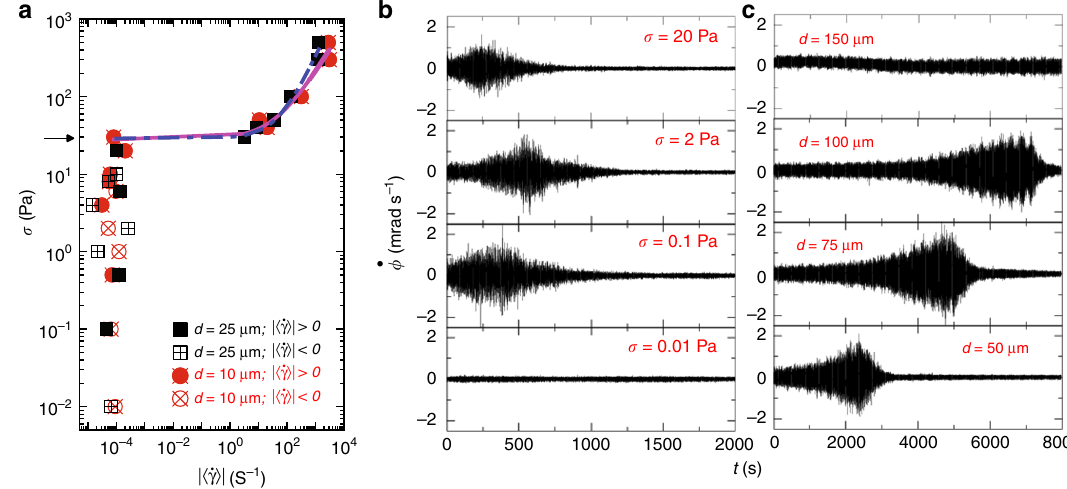
Fig. 1 Steady-state fl ow curves and creep behavior of CTAT nematic . a Applied shear stress ( σ ) versus absolute value of steady-state shear rate ( jh _ γ ij , calculated considering data from 2000s to 8000 s for each stress value) for 39 wt % CTAT + water sample at 30 °C (nematic phase of cylindrical micelles) is plotted for two different sample thicknesses ( d ). Filled symbols indicate positive and empty symbols indicate negative values of h _ γ i . Solid curve ¼ 28 Pa, 29 Pa (indicated by the arrow) and power n ¼ 0 : 62 ; 0 : 81 for d ¼ 10 μ m, 25 µ m, and dash-dot curve are Herschel – Bulkley fi ts with yield stress σ y respectively. b Angular velocity of the top plate ( _ ϕ ) as a function of time ( t ) is plotted for four different σ with same sample thickness d ¼ 10 μ m (see Supplementary Fig. 3 for the expanded version of the σ ¼ 2 Pa data), and c shows plots for four different d with same applied stress σ ¼ 2